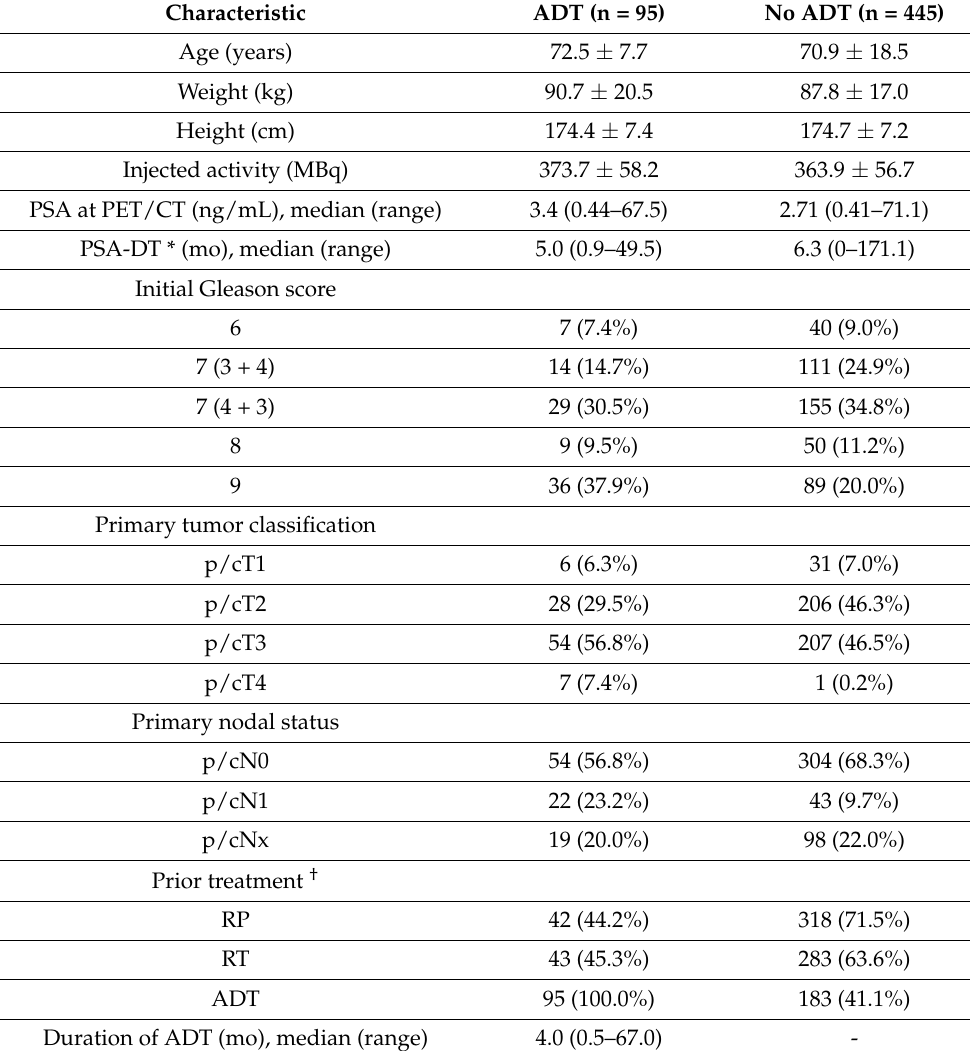
Table 1. Patient characteristics and treatment